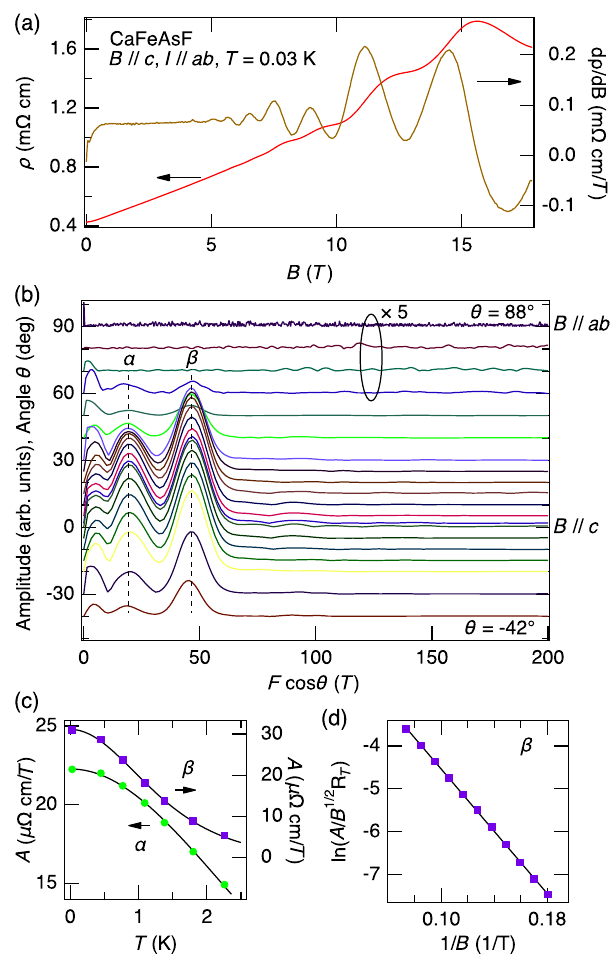
FIG. 3. (a) In-plane resistivity in CaFeAsF and its magnetic-field derivativeasafunctionof B appliedparalleltothe c axis.(b)Fourier transforms of d ρ =dB vs 1 =B over the field range 5 – 17.8 T for various field directions θ . Note that the horizontal axis is F cos θ . The spectra are vertically shifted so that the baseline of a spectrum for an angle θ is placed at θ of the vertical axis. (c) Temperature dependence of the α and β oscillation amplitudes for B ∥ c . The curves are fits to the temperature reduction factor R . (d) Dingle T plotforthe β frequency for B ∥ c . Thevertical axis is a logarithm of a reduced amplitude. The line is a linear fit.